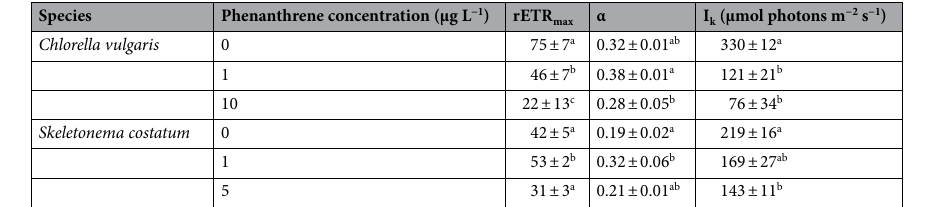
Table 1. The maximum relative electron transport rate (rETR max ), apparent photon transfer efficiency (α), and light saturation point (I k ) (μmol photons m −2 s −1 ) of Chlorella vulgaris and Skeletonema costatum cells at different phenanthrene concentrations. The different superscript letters indicate significant ( p < 0.05) differences between phenanthrene concentrations in one species (one-way ANOVA and post-hoc Tukey tests).